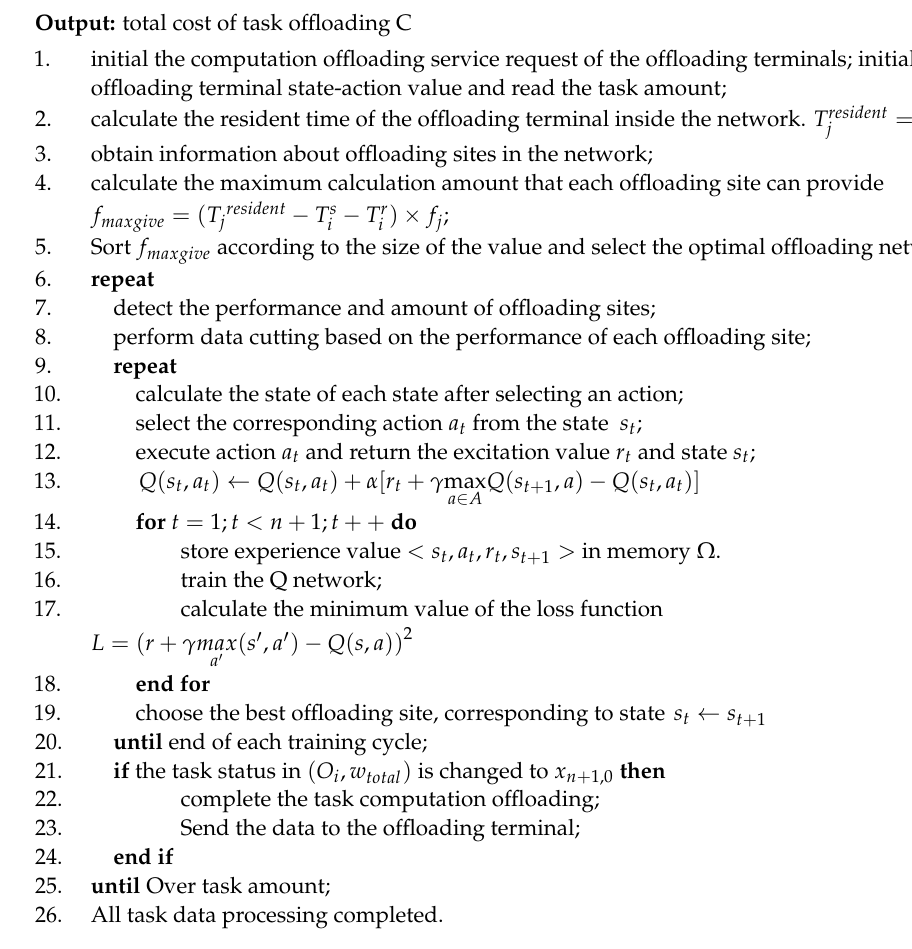
Algorithm 1 Computation Offloading Algorithm Based on